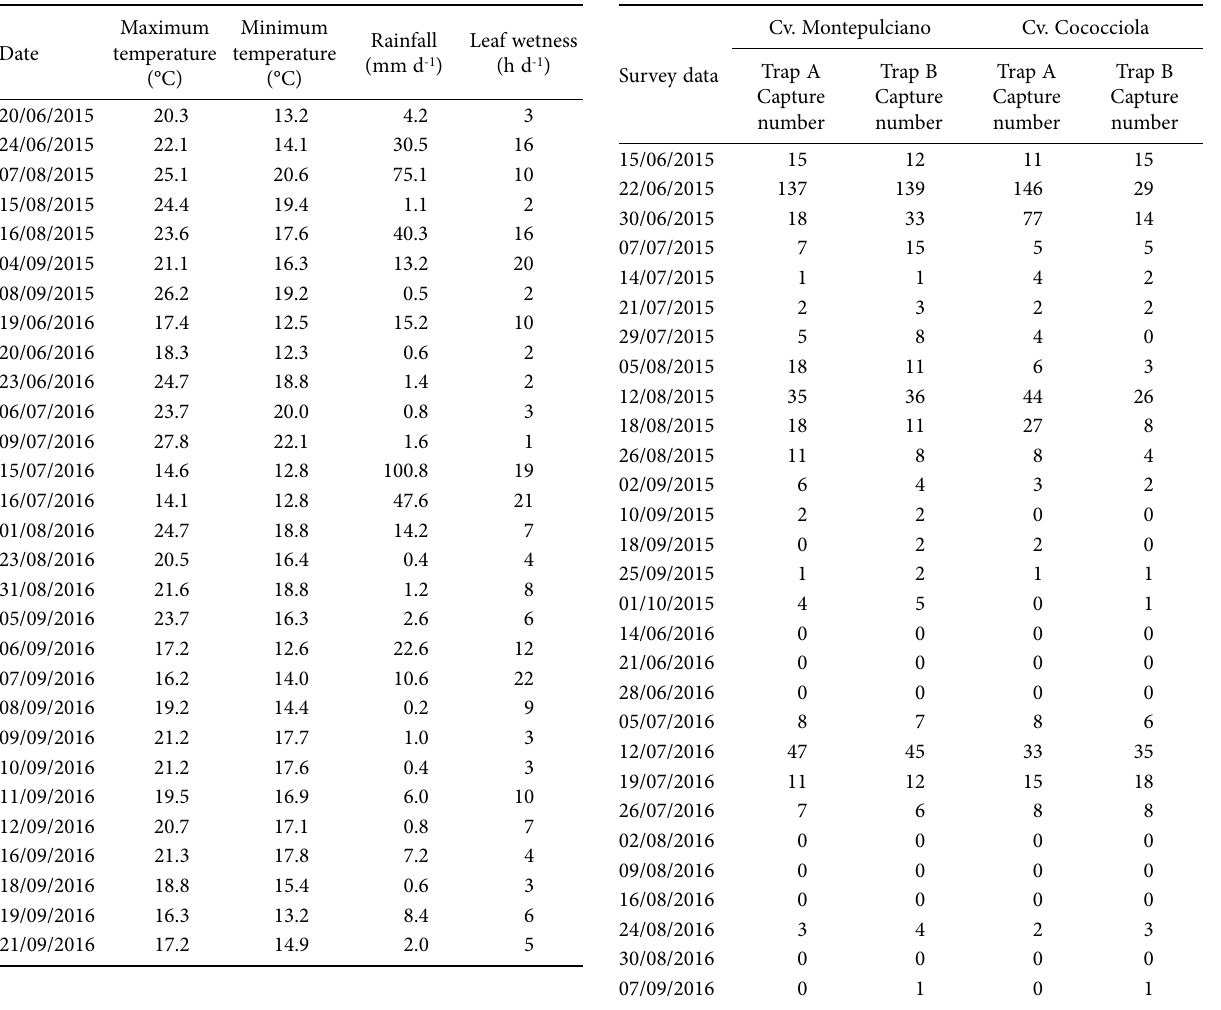
Table 3. Rainfall, temperature and leaf wetness periods on rainy days at the ARI vineyard in 2015 and 2016.